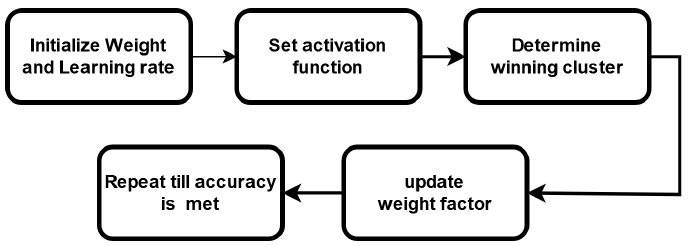
Figure 5. Block diagram of a CNN for pattern